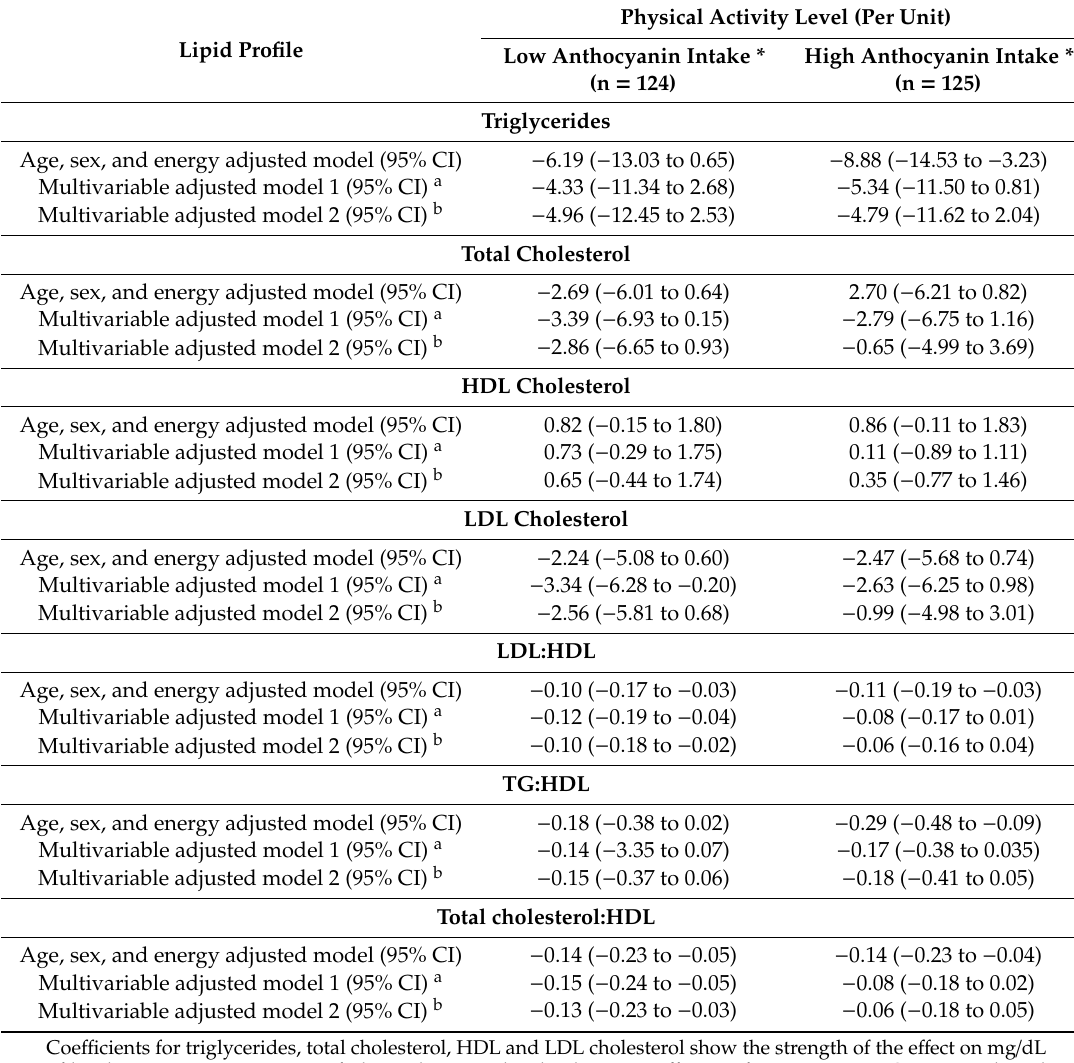
Table 4. Association ( β , 95% CI) between physical activity (independent variable in level units) and di ff erent lipid parameters (mg / dL) stratified by subgroups of low and high anthocyanin intake.